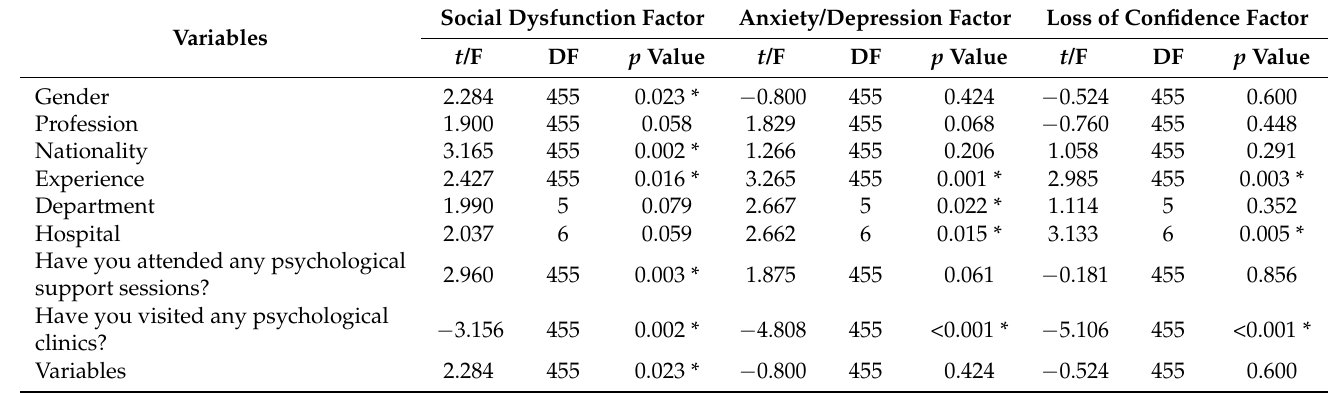
Table 5. The association between socio-demographic characteristics with GHQ-12 factors (social dysfunction factor, anxiety/depression factor, and loss of confidence